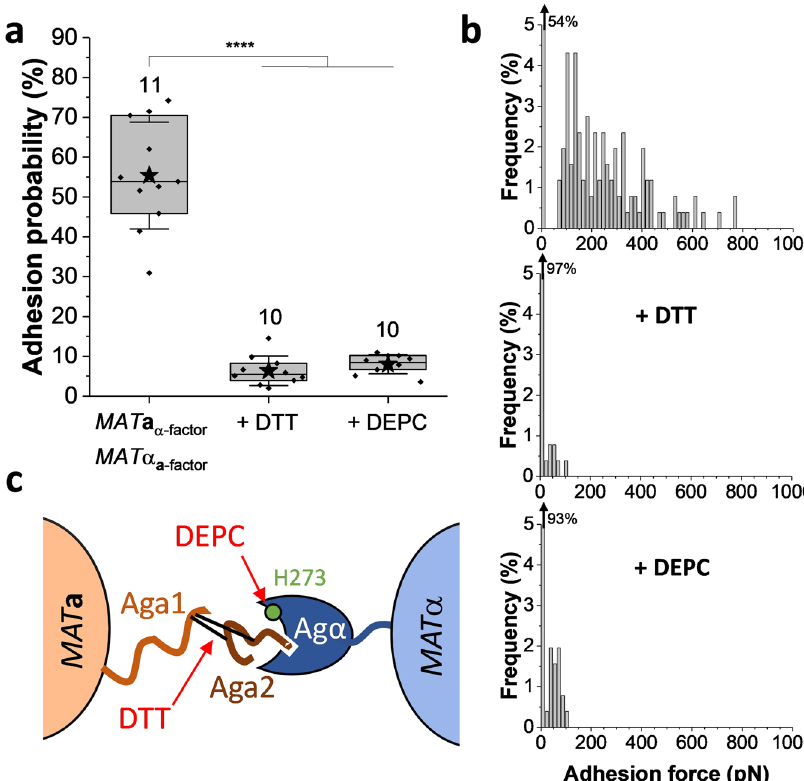
Fig. 5 Agglutination forces critically depend on disul fi de bonds and His 273 residues. a In fl uence of DTT and DEPC treatments on the adhesion probability between N independent MAT a and MAT α cell pairs ( N is indicated above the corresponding boxes) pretreated with pheromones. Stars are the mean values, lines the medians, boxes the 25 – 75% quartiles, and whiskers the SD from N independent cell pairs. Student ’ s t test: **** p ≤ 0.0001. b Representative unbinding force histograms before and after injection of DTT or DEPC. Percentage on the top left corner stands for the non-adhesive events. c Scheme of the molecular mechanism involved in the interaction between a - and α -agglutinins, showing the binding sites of both agglutinins and the regions targeted by DTT and